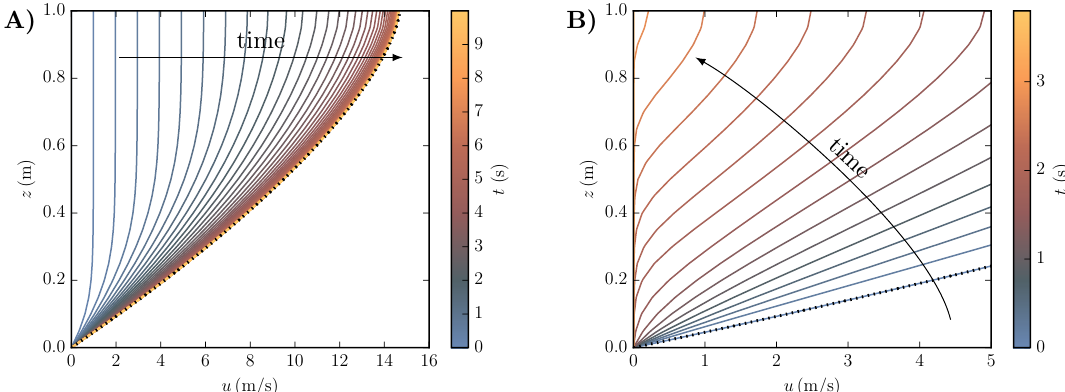
Figure 1. Velocity profile of an infinitely long avalanche with colour marking the time. ( A ) Acceleration on an inclined plane. The simulation started from rest, the velocity profile tends to the Bagnold profile in steady state (black dotted line). ( B ) Deceleration on a flat plane. The simulation started with the steady state Bagnold profile of an inclined plane from panel A, and leads to a gradual deposition starting from the